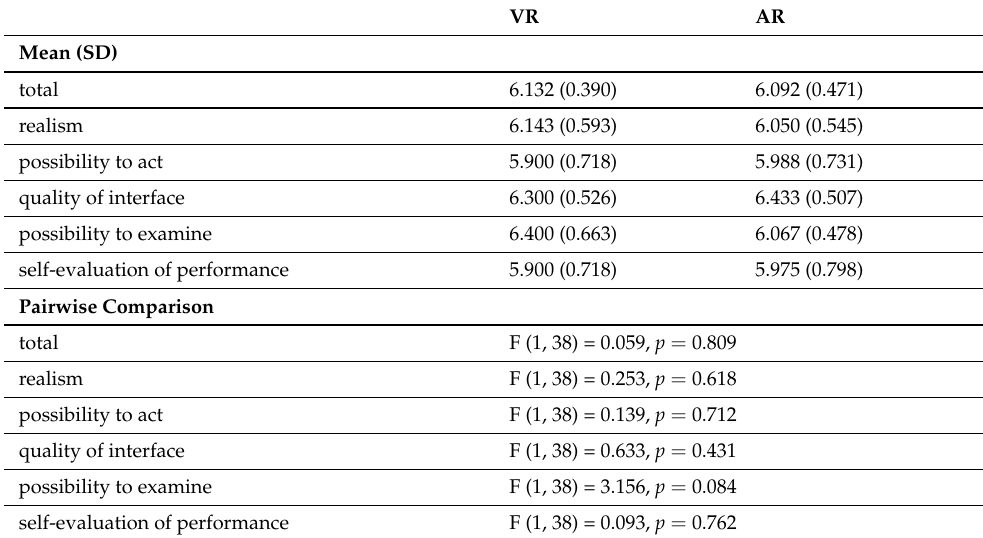
Table 2. Comparative analysis result of presence experienced by each user in asymmetric experience environment